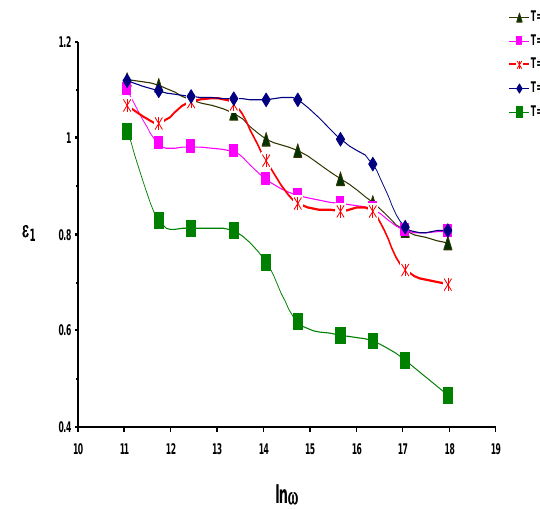
Fig.2: Variation of real part of permittivity (ε ) with frequency of PMMA films for 1 different temperatures